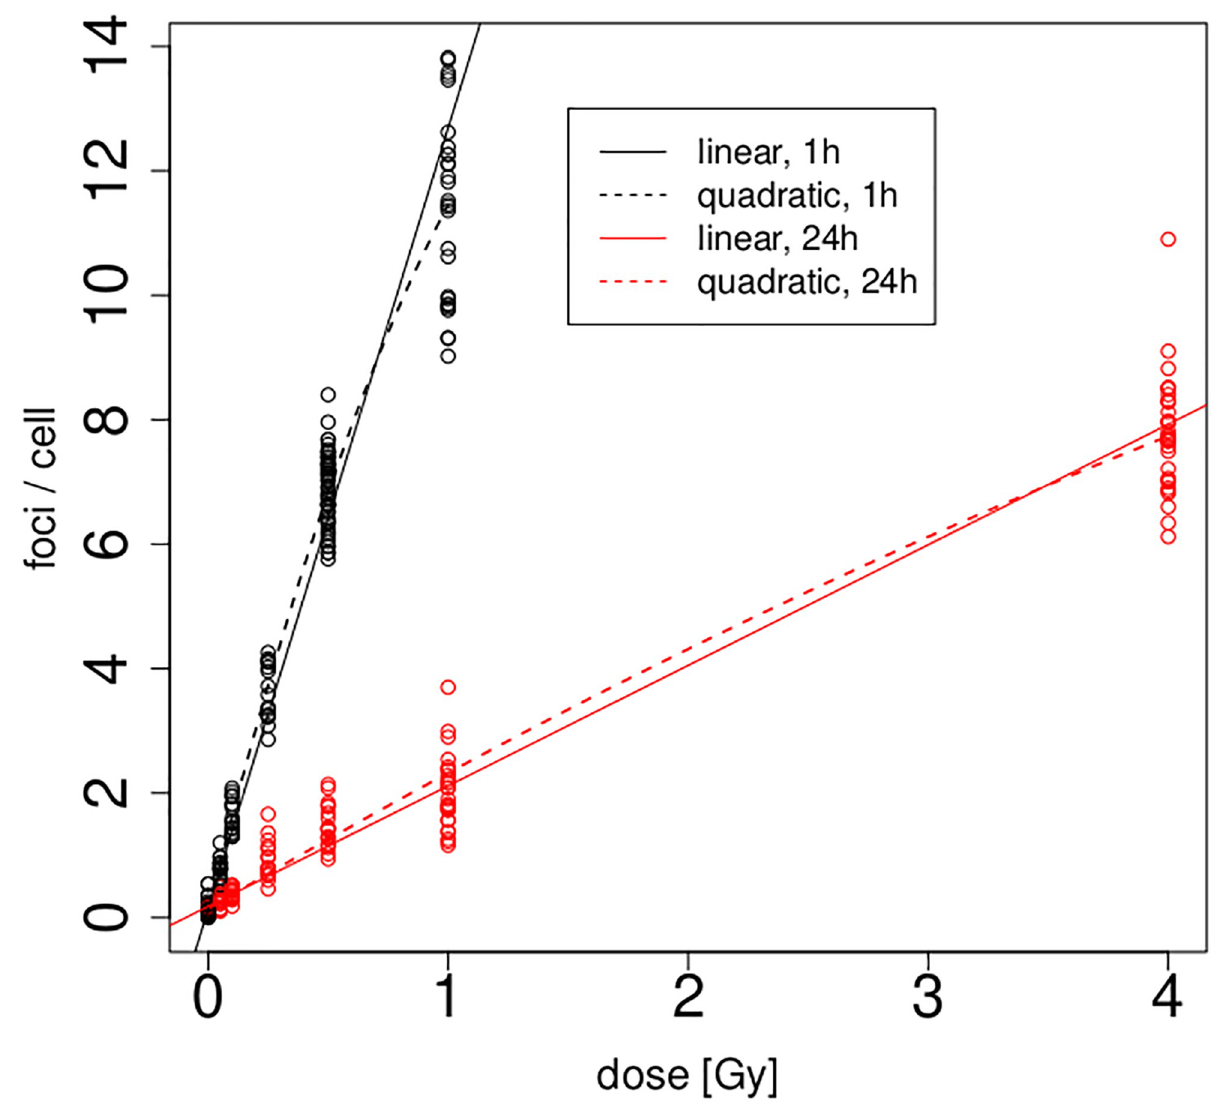
Fig 2. Linear (solid) and quadratic (dashed) calibration curves fitted to 1h and 24h data.